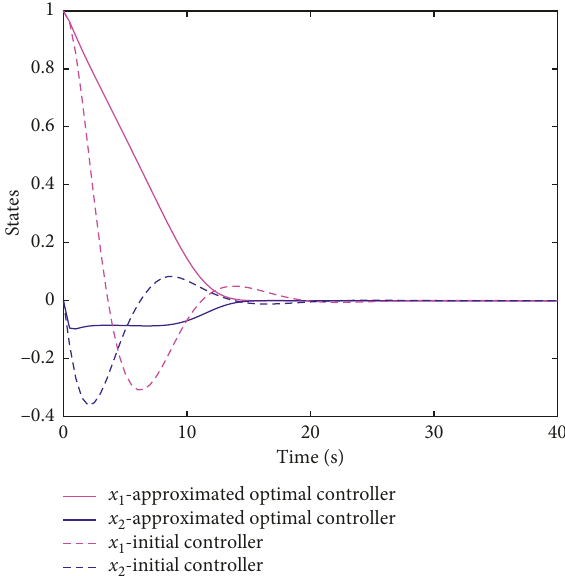
Figure 1: State trajectories driven by initial admissible control and approximated optimal control.